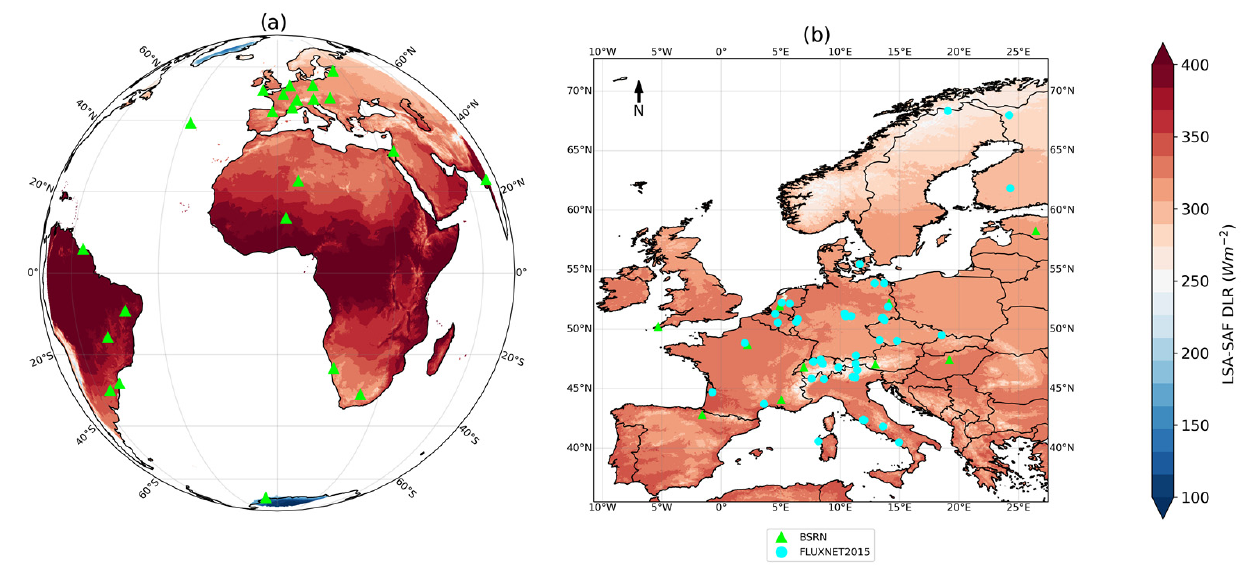
Figure 1. ( a ) Example of the annual mean (2020) downward long-wave radiation (DLR) at the surface estimated with the LSA-SAF operational algorithm within the Meteosat Second Generation (MSG) disk, including the location for each of the 23 Baseline Surface Radiation Network (BSRN) ground stations marked by the green triangles; ( b ) Zoom of the European region, including both BSRN and also the FLUXNET2015 48 ground stations marked by the cyan circles. Table 1. List of 23 stations used within the Meteosat Second Generation (MSG) disk for validation purposes of estimated downward long-wave radiation (DLR) at the surface. The name, acronym, network of origin, location, geographical coordinates ( ◦ ), elevation (m), availability (total number of years available between 2004 and 2019), and annual mean DLR (W · m − 2 ) for each station is shown. Annual DLR Latitude and Avail. (Years) (W · m − 2 Longitude ( ◦ )